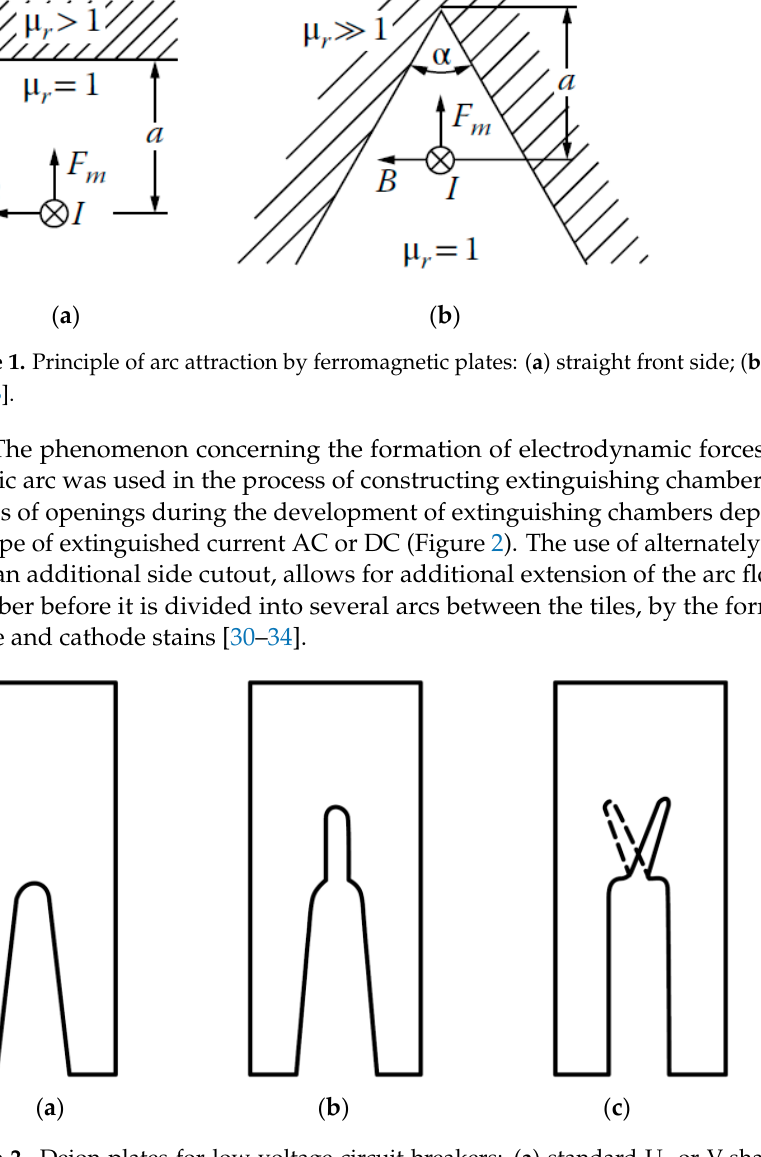
Figure 2. Deion plates for low-voltage circuit-breakers: ( a ) standard U- or V-shaped recess (AC applications); ( b ) with central slot; ( c ) with staggered slots (DC applications).